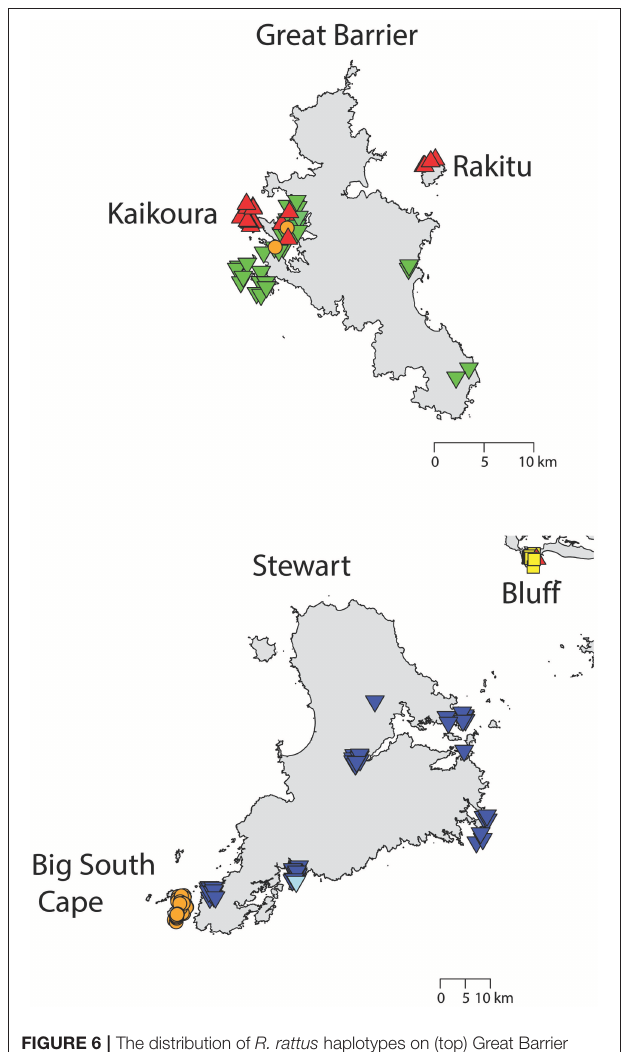
FIGURE 6 | The distribution of R. rattus haplotypes on (top) Great Barrier Island and neighboring islands, = RatHap01, = RatHap02, = RatHap04, RatHap05 & RatHap06; and (bottom) Stewart Island and neighboring islands, = RatHap01, = RatHap02, = RatHap03, = RatHap07, RatHap08 &